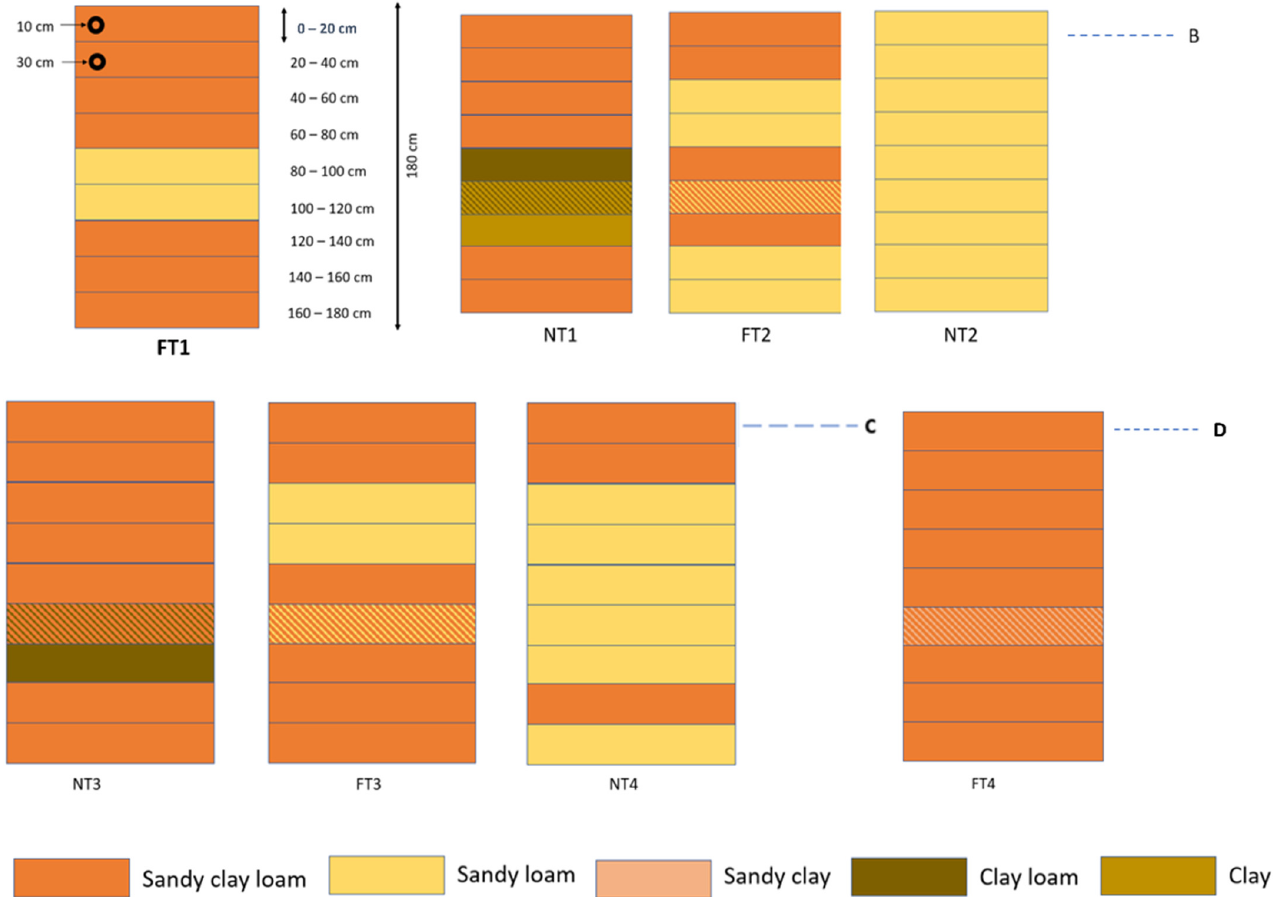
Figure 3. Soil types in layers for plots in study. The hatched lines represent mixed soils. B, C, and D represent transects shown in Figure 2.